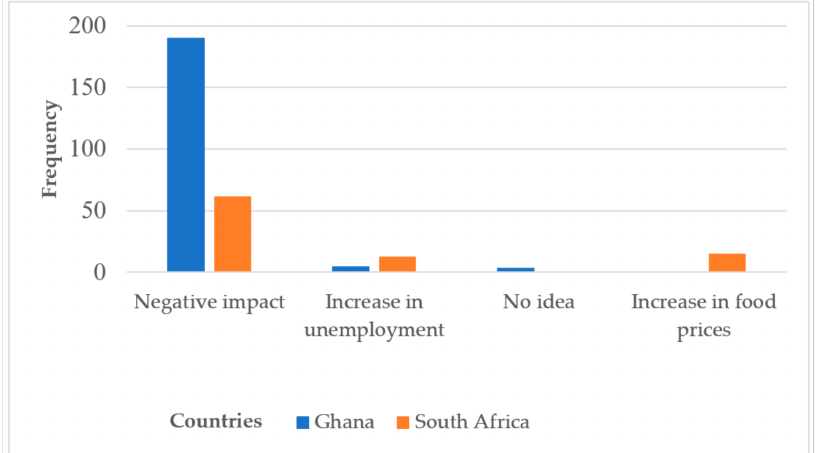
Figure 2. Market women’s opinions about the impact of COVID-19 on their